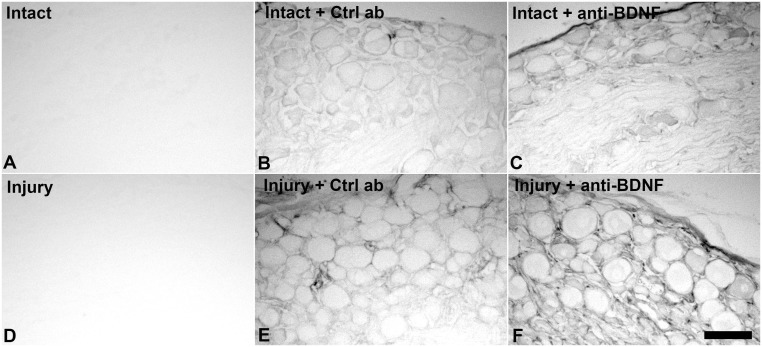
Intrathecally infused anti-BDNF and control IgGs effectively penetrate DRG tissue.Brightfield photomicrographs of L5 DRG sections with or without antibody infusions, depicting antibody penetration into intact DRG or 3 days following sciatic spinal nerve injury. Both control sheep IgGs and sheep anti-BDNF antibodies readily penetrate the tissue after intrathecal delivery showing immunoreactivity both in the parenchyma and the surrounding connective tissue in intact (B, C) and injured (E, F) animals. Note, no staining for sheep IgGs is found in DRGs from animals not receiving antibody infusions (A, D). Scale bar 100 µm.